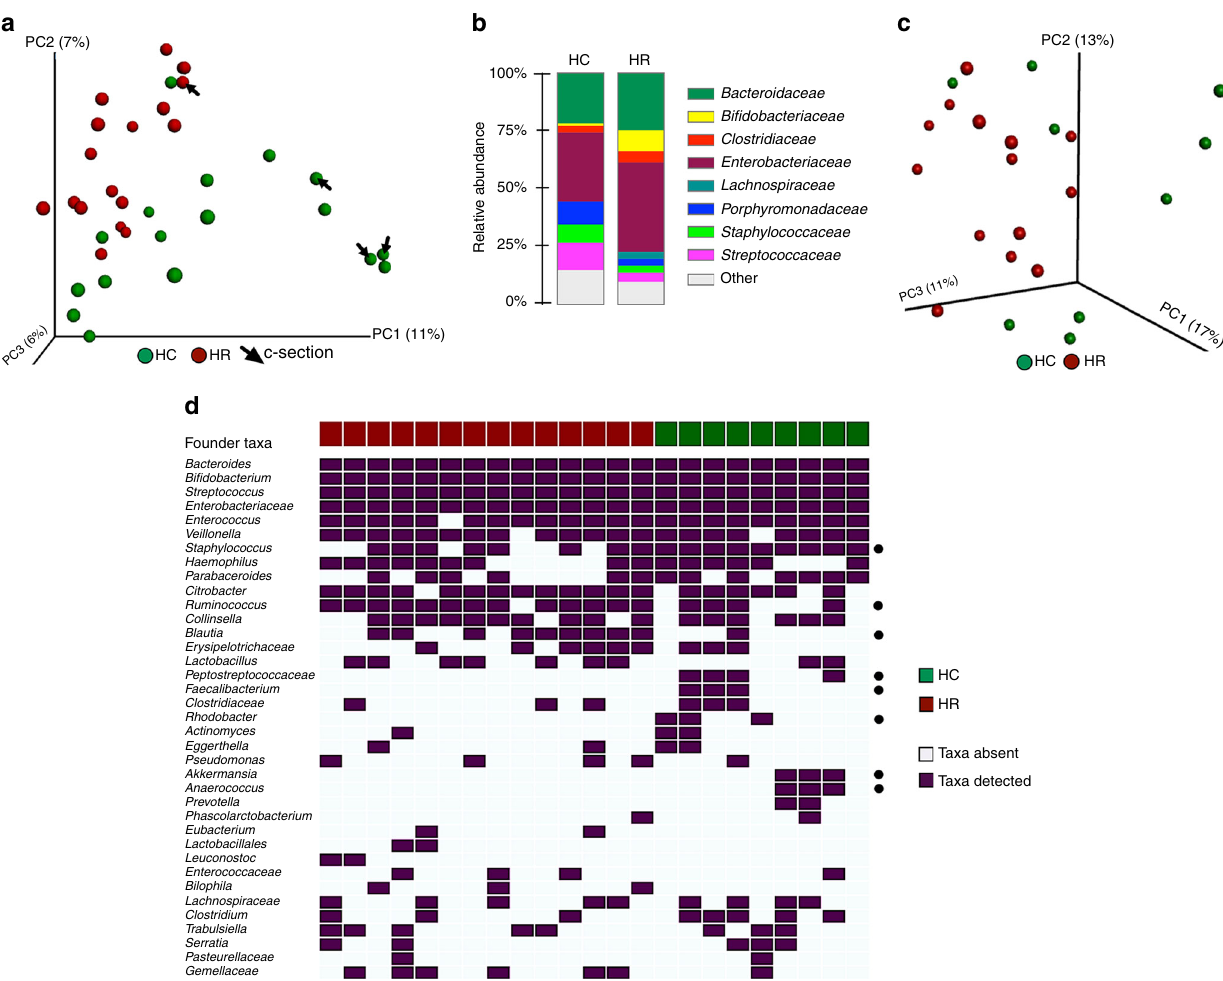
Fig. 2 Meconium microbiota and persistent founder taxa signi fi cantly differ in high risk for asthma (HR) and healthy control (HC) subjects. a Principal Coordinates analysis (PCoA) of meconium microbiota indicates signi fi cantly different composition based on asthma risk status (HR n = 18; HC n = 17; Unweighted UniFrac; PERMANOVA R 2 = 0.062, p = 0.001). b Taxon summary plot indicates expansion of Enterobacteriaceae and Bacteroidaceae in vaginally born HR ( n = 17) meconium compared to HC ( n = 14) neonates. c Persistent founder microbiota differ in HR ( n = 14) and HC ( n = 9) participants (Unweighted UniFrac; PERMANOVA R 2 = 0.081, p = 0.018). d While a number of persistent founder taxa are common to both HC ( n = 9) and HR ( n = 14) subjects, several differ (Fisher ’ s exact test; p < 0.05; black dots), including a number whose depletion has previously been associated with atopy